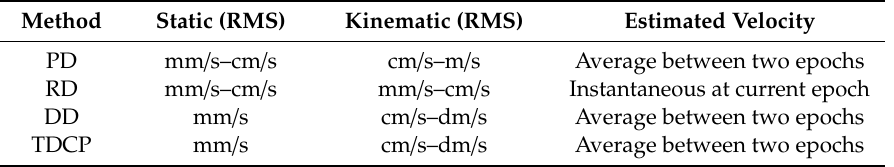
Table 1. Comparison of four velocity estimation